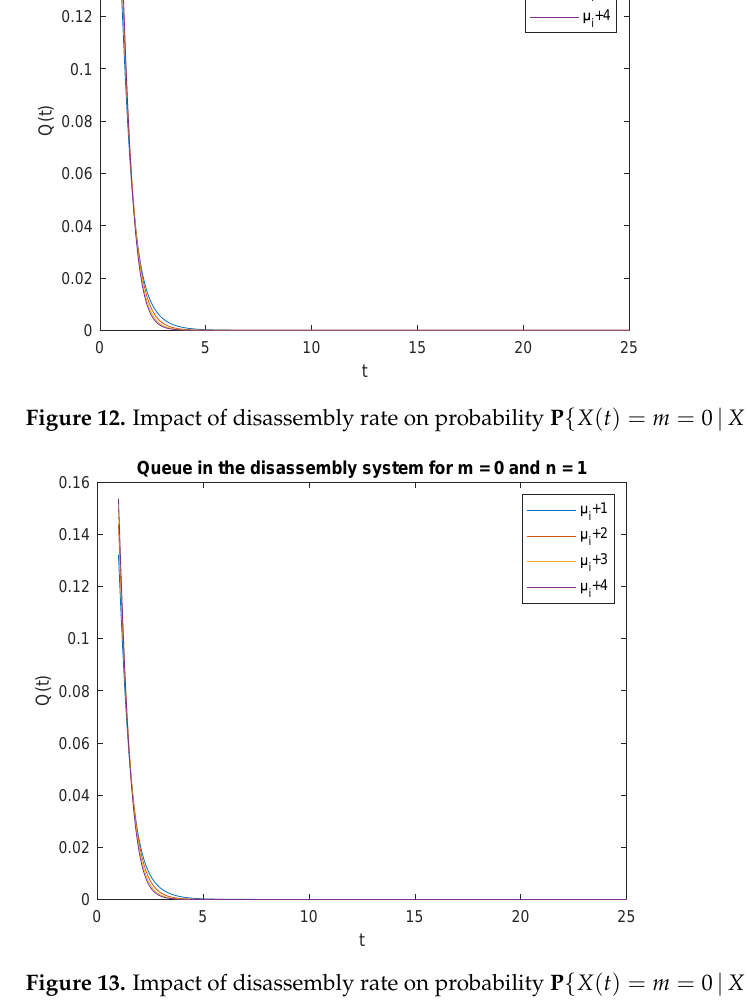
Figure 13. Impact of disassembly rate on probability P { X ( t ) = m = 0 | X ( 0 ) = n = 1 } for λ =